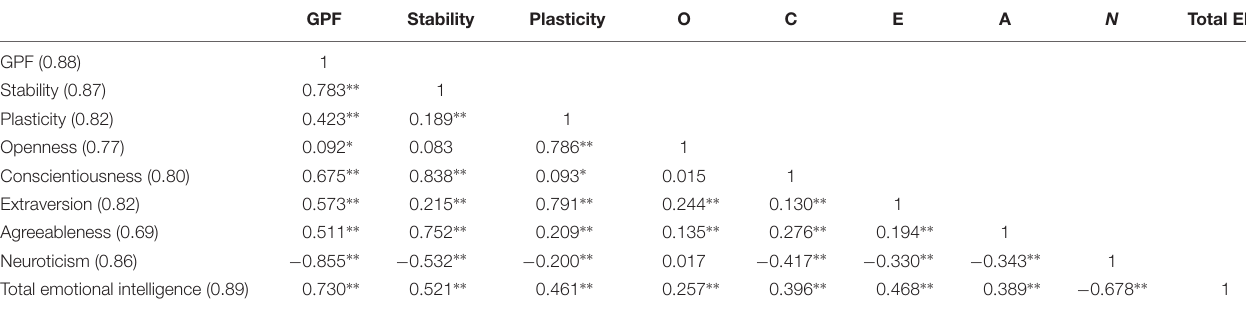
TABLE 1 | Inter-correlations among TEI, the B5, the B2, and the GFP. GPF Stability